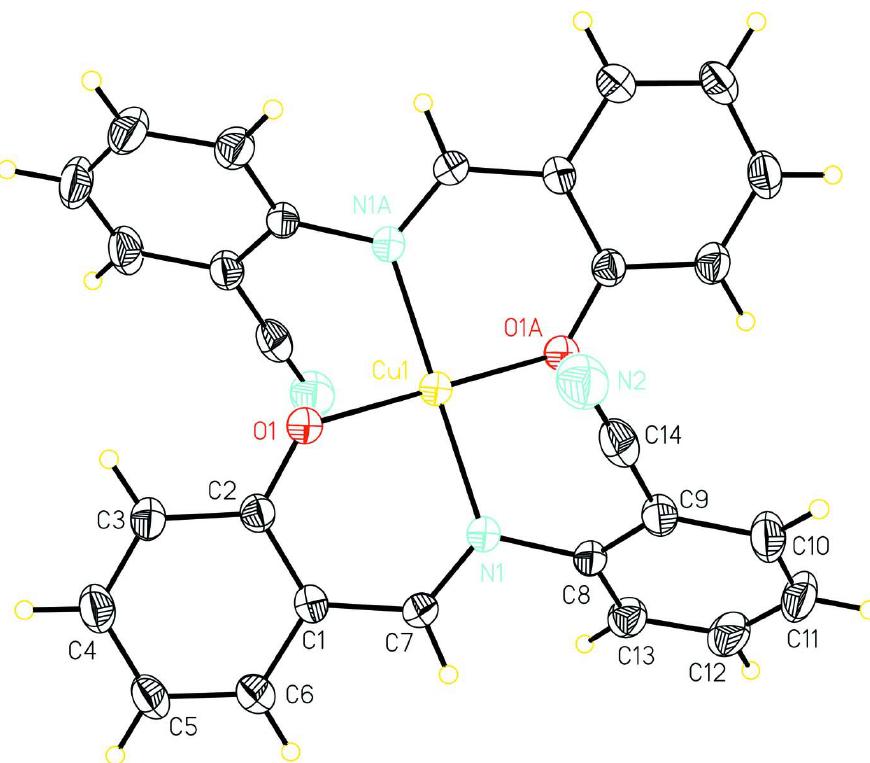
Molecular view of the title compound with the atom-labelling scheme. Displacement ellipsoids are drawn at the 30% probability level. H atoms are represented as small spheres of arbitrary radii. [Symmetry code: (i) 2 - x , 1 - y , - z